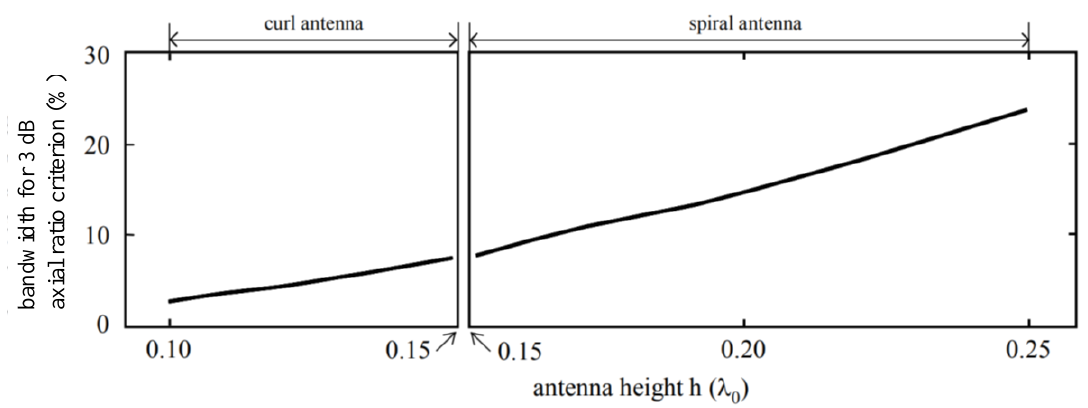
Figure 3. CP wave bandwidth versus antenna height h .